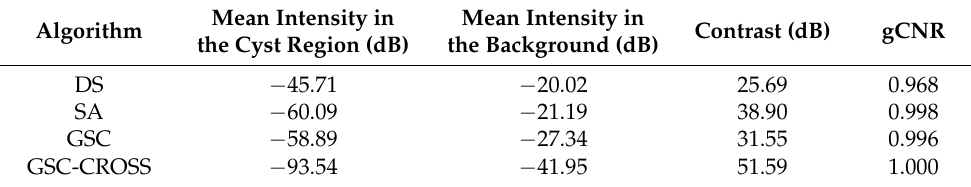
Figure 6. Lateral variation at z = 40 mm of Figure 5. Table 2. Contrast and gCNR of beamforming responses for different beamforming algorithms.